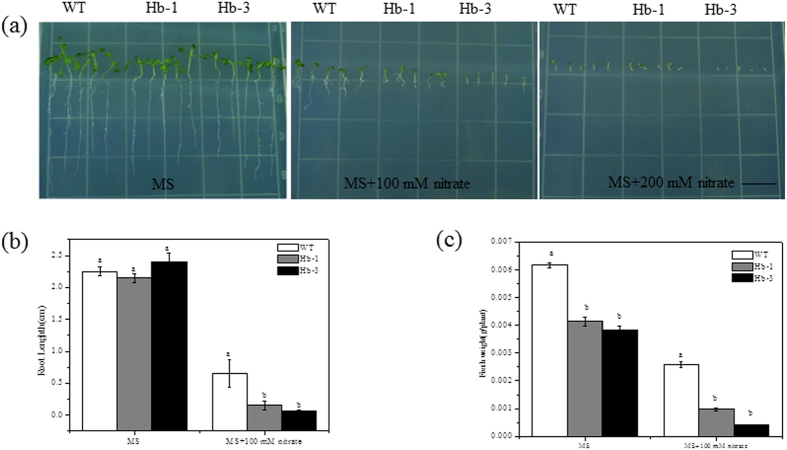
Effect of excess nitrate stress on the growth of SoHb transgenic Arabidopsis.Seedling morphology (a), root length (b), fresh weight (c) of the WT and transgenic lines grown on MS medium supplemented with 100 and 200 mM nitrate for 7 days.